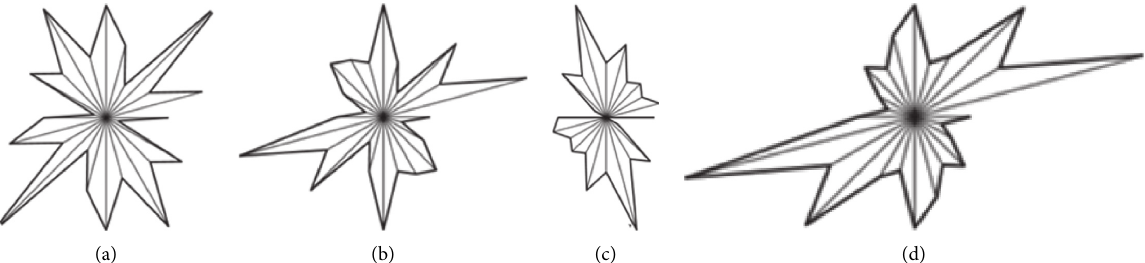
Figure 20: Roses of oriented arrangement of red clay particles under different wet and dry cycles. (a) 0 cycles. (b) 3 cycles. (c) 6 cycles. (d) 9